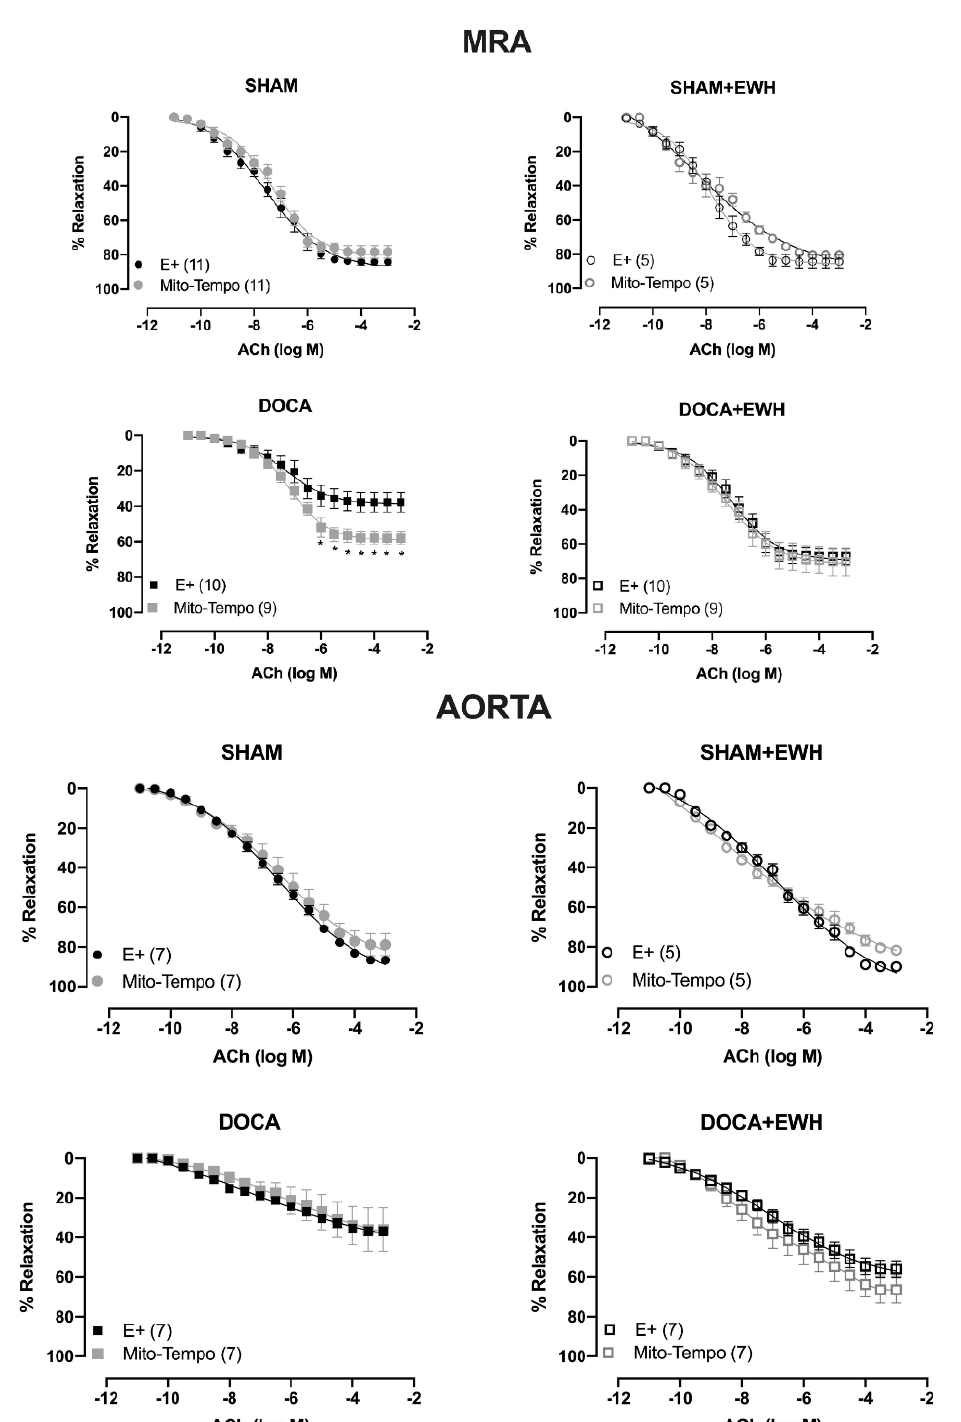
Figure 5. The role of EWH in ROS-mediated ACh-induced relaxation in MRA and aorta of DOCA- salt rats. Concentration–response curves to ACh were obtained in MRA (Upper graphics) and aorta (Bottom graphics) segments from rats from SHAM, SHAM+EWH, DOCA, and DOCA+EWH groups before (E+) and after incubation with scavenger reactive oxygen species, the superoxide dismutase (SOD, 750/mL). The results are expressed (mean ± SEM) as the percentage of relaxation responses in norepinephrine or phenylephrine precontracted rings. The number of animals in each group is in parentheses. Two-way ANOVA followed by Bonferroni post-test: p < 0.05 * vs. E+.